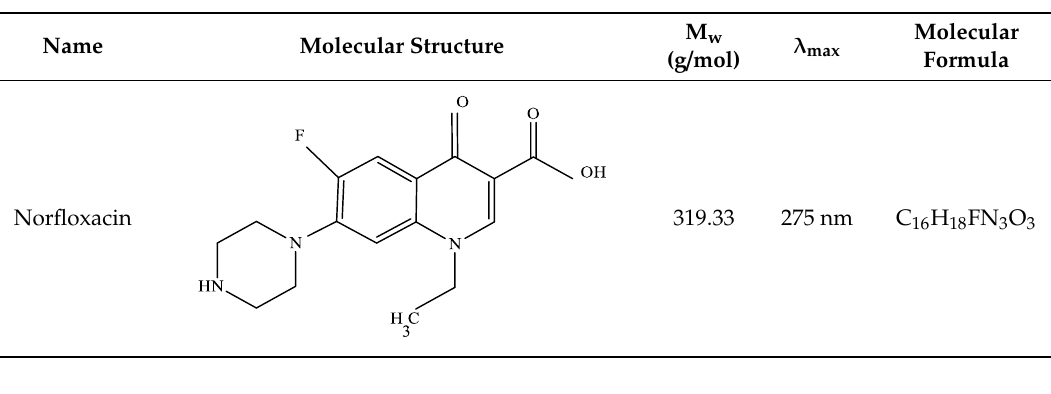
Table 1. Physicochemical characteristics of norfloxacin.